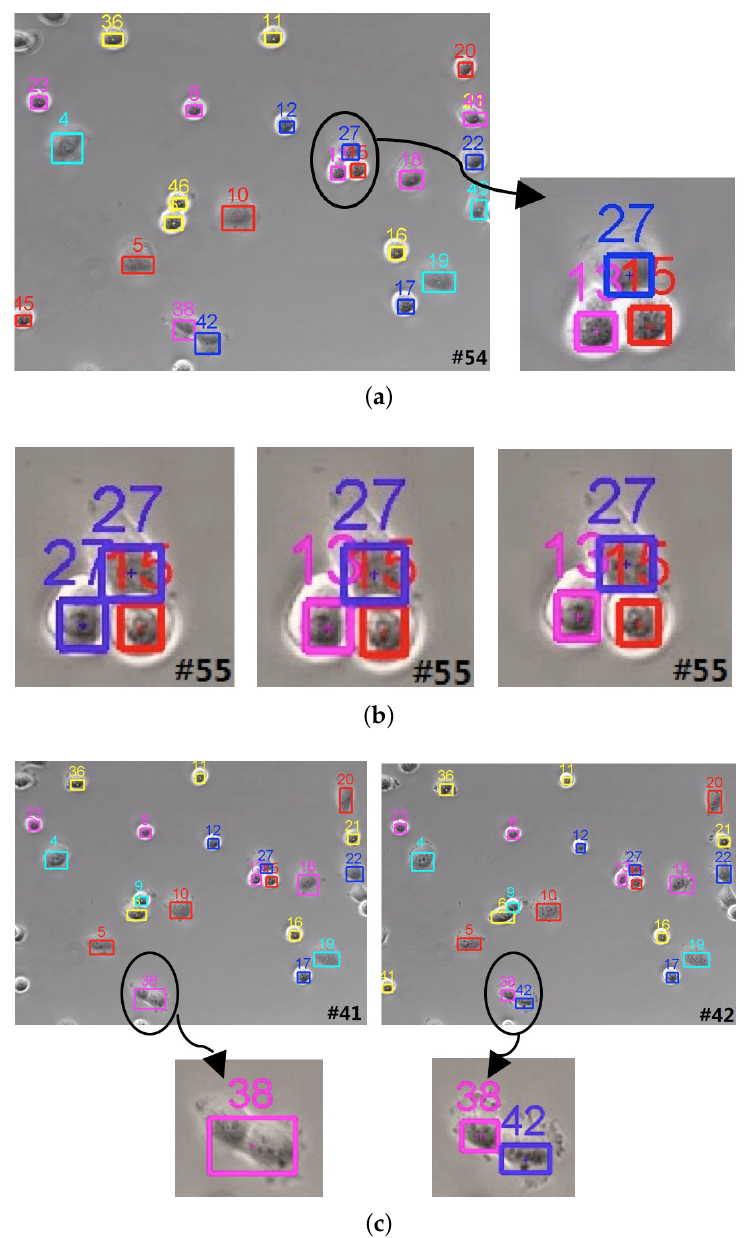
Figure 11. Tracking results on a cell moving surveillance scenario. ( a ) Left: tracked targets at t = 54; right: local tracked targets; ( b ) from left to right: tracked targets at t = 55 by the GM-PHD tracker, by the CPGM-PHD tracker and by our tracker, respectively; ( c ) from left to right: tracked targets by our tracker at t = 41 and t = 42,